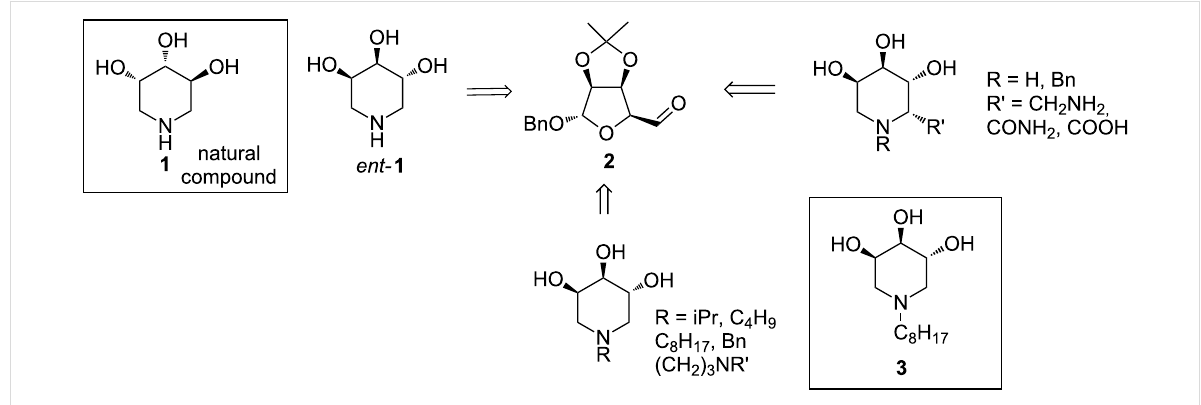
Scheme 1: Double reductive amination on aldehyde 2 allowed the synthesis of trihydroxypiperidines, among which the enantiomer of natural com- pound 1 and the N -alkylated piperidine 3